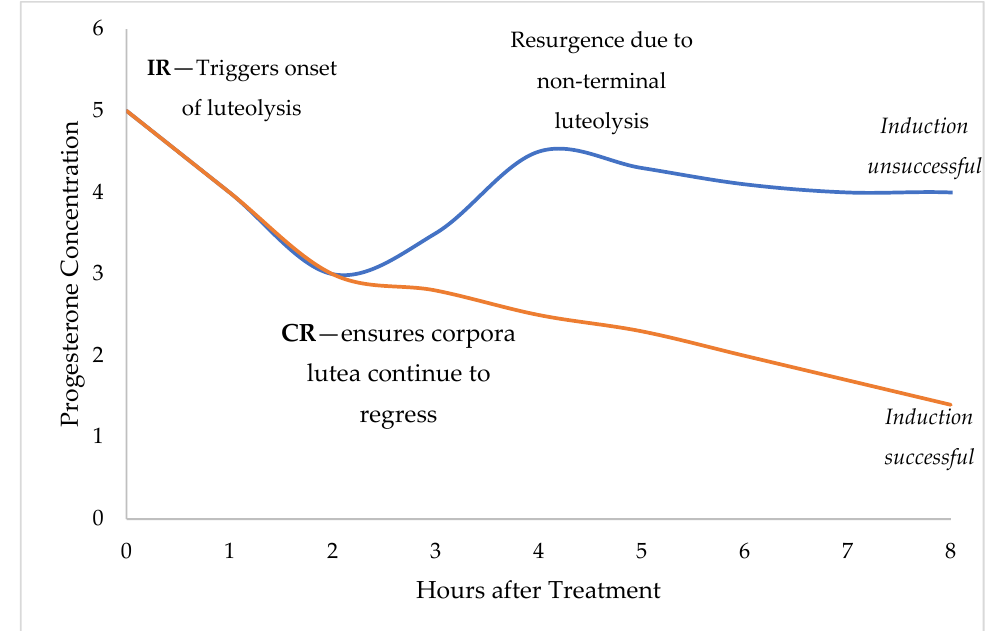
Figure 2. Graphical representation of how progesterone concentrations in sows are predicted to respond to the IR and CR formulations. An ideal RR NVDDS would trigger onset of luteolysis (orange and blue line). Administering the CR NVDDS should release cloprostenol gradually, triggering complete regression and result in a successful induction (orange line). Without the CR NVDDS, risk of resurgence due to non-terminal luteolysis could result in an unsuccessful induction (blue line).